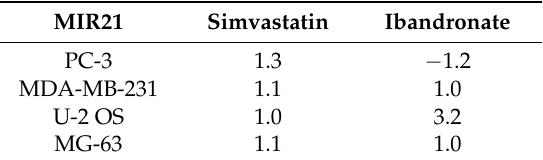
Table 10. Fold upregulation of MIR21